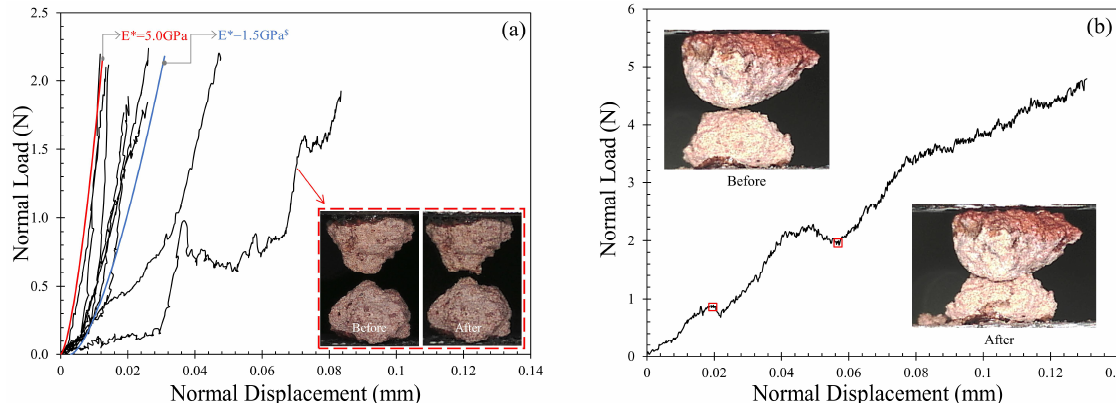
Figure 5. Normal contact response of MMS-1 grains ( a ) at maximum load of 2 N with an indication of contact modulus range and ( b ) at maximum load of 5 N ( $ initial shift in normal displacement applied).